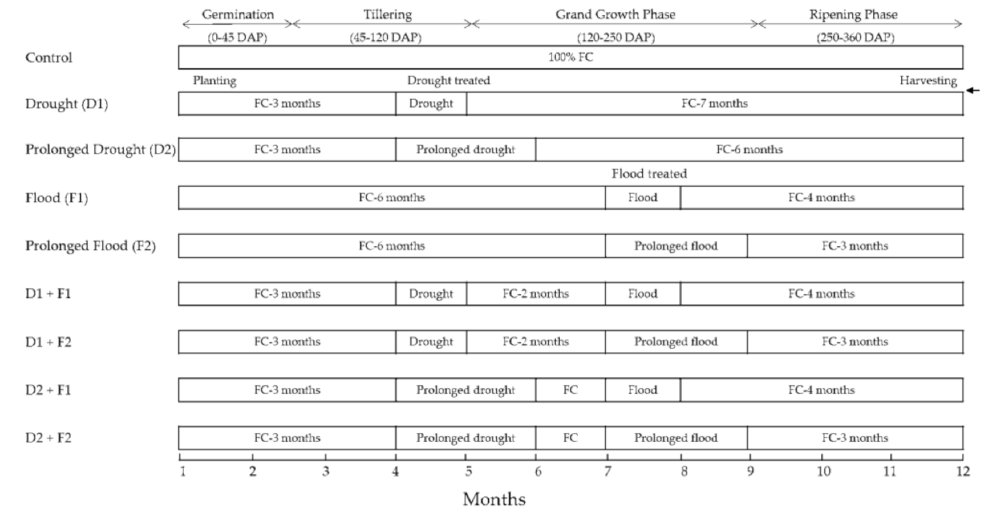
Figure 1. Period of drought and flood exclusion treatments, drought = 50% of FC, flood = maintaining water level at 10 cm above soil